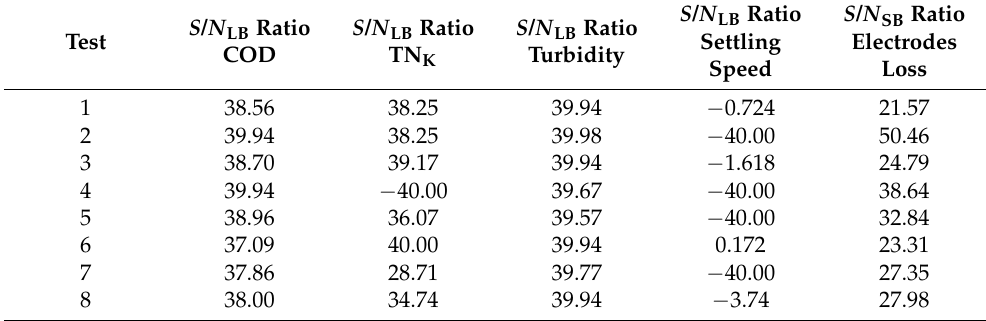
Table 8. S/N LB and S/N SB